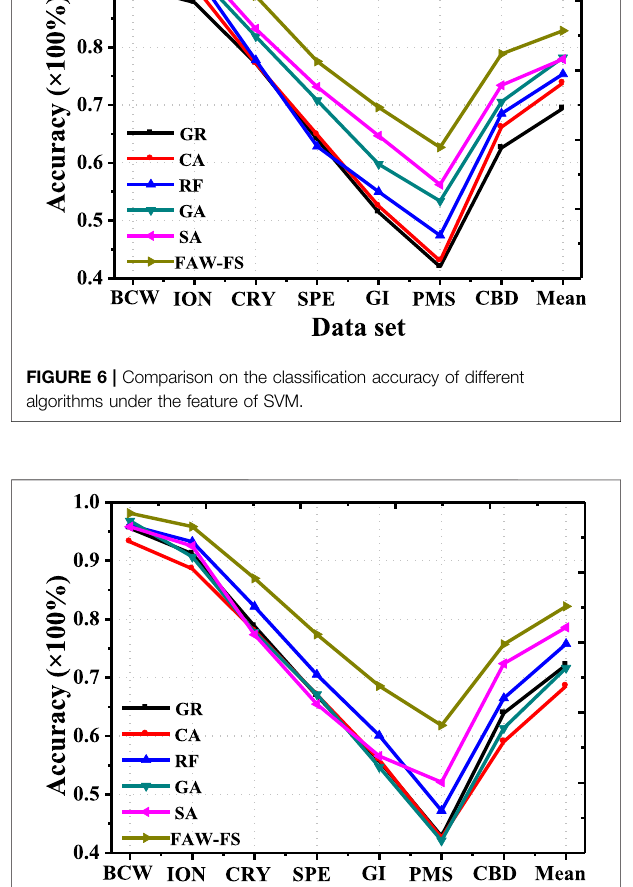
Figure 6 indicated that the classi fi cation accuracy of the 6 algorithms was compared under the features of SVM. In the 7 different data sets, the classi fi cation accuracy of the FAW-FS algorithm was higher hugely than that of other algorithms, and its classi fi cation accuracy was within 62.33 – 99.07%, with the mean classi fi cation accuracy of 83.07%.